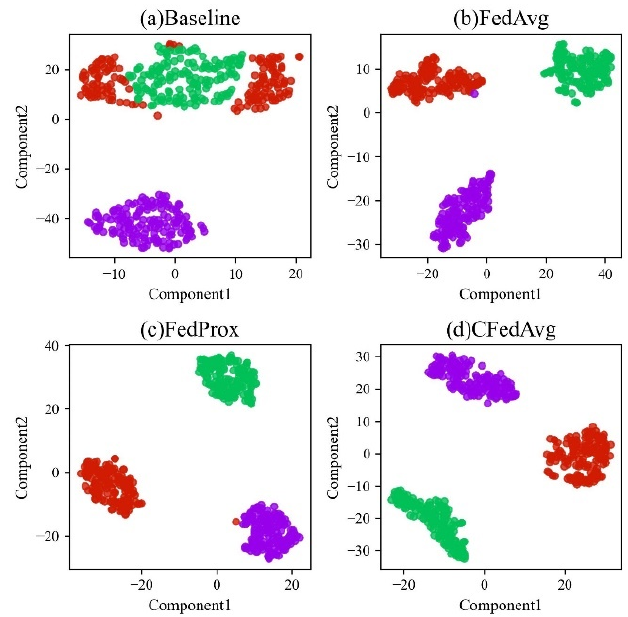
Figure 9. The visual result of different federated methods.